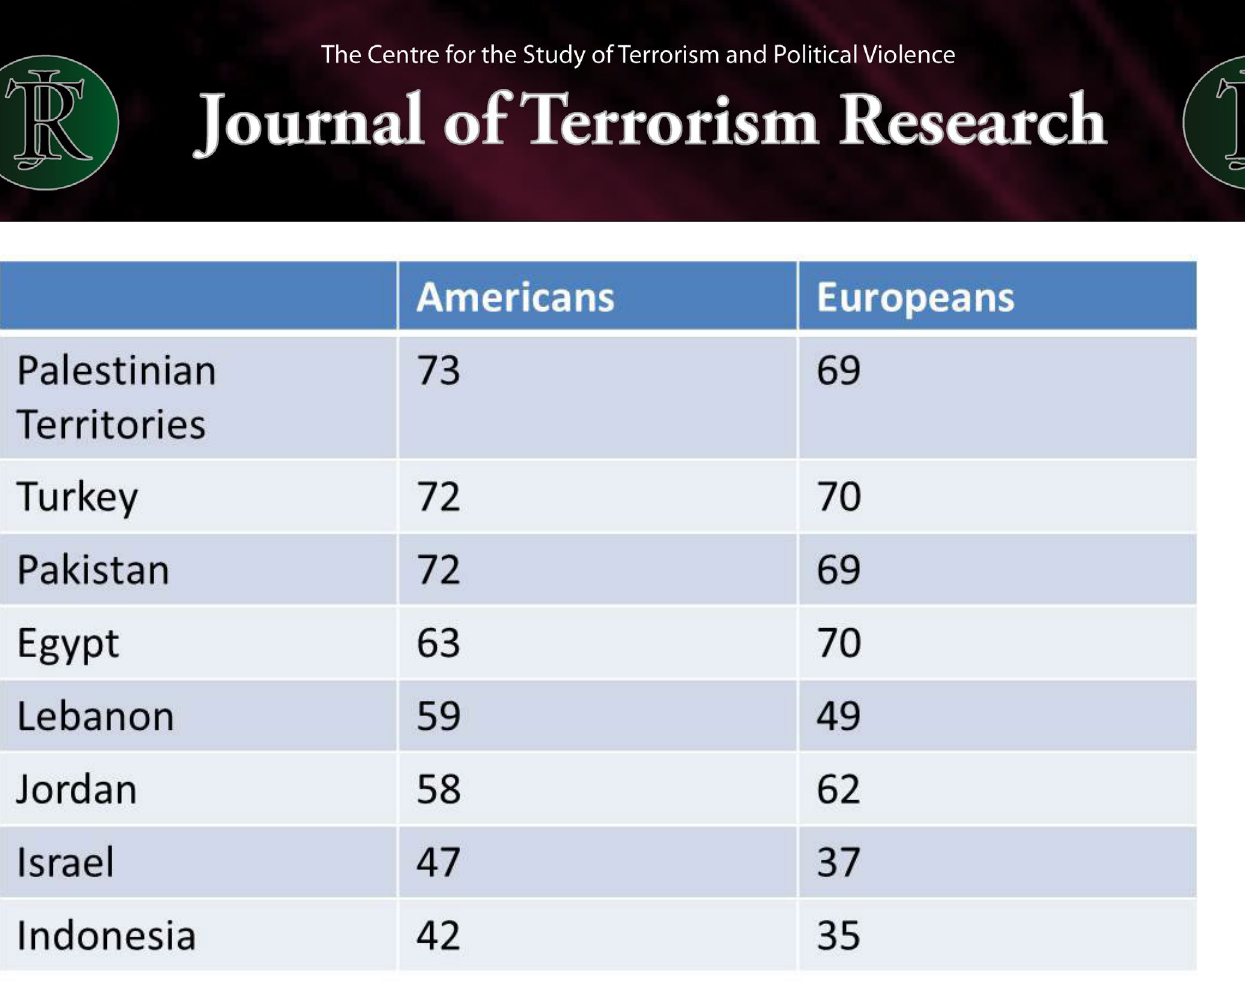
Figure 1: Median percentage of Muslims who perceive the Americans and Europeans as hostile to the Muslims according to a 2011 Pew Global